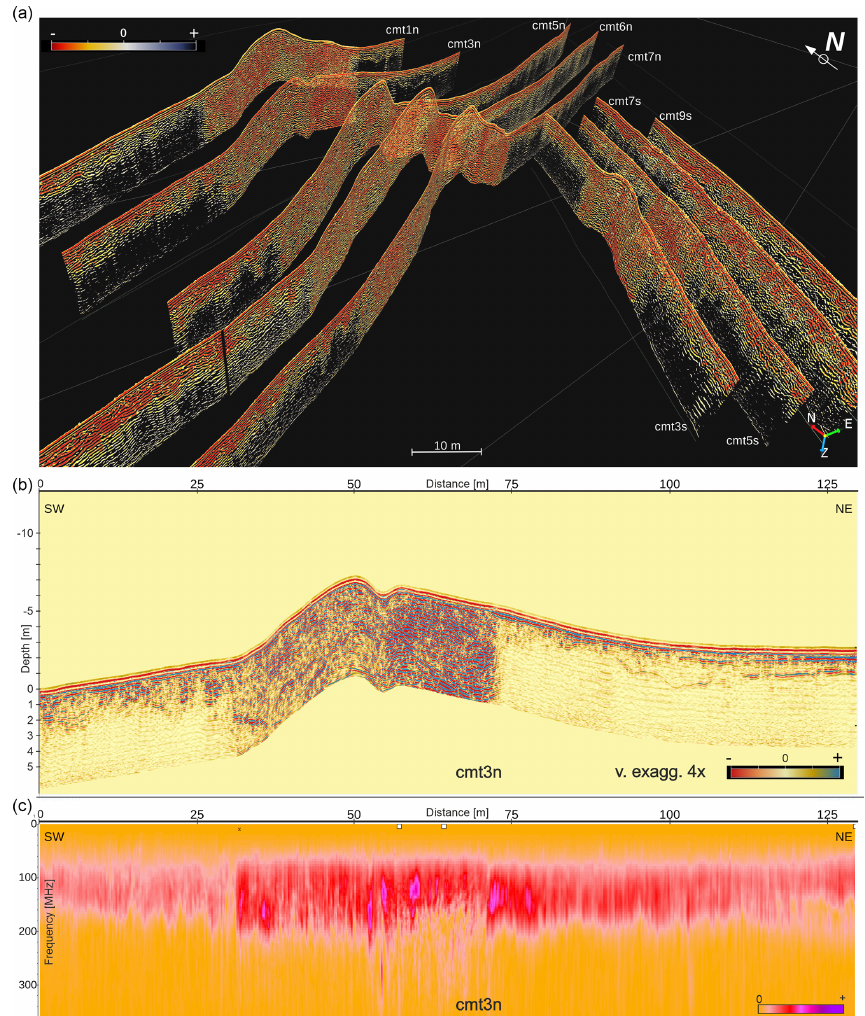
Figure 6. GPR data visualization: (a) fence diagram showing the three-dimensional location of some representative GPR profiles in the northern sector of the study site; (b) bidimensional GPR profile (cmt3n; see Fig. 2a for location) displaying the central high reflective sector and dipping reflections across the hill; (c) spatial variation of a 2D amplitude-frequency spectrum linked to variable physical properties of media along the profile cmt3n. Vertical exaggeration is